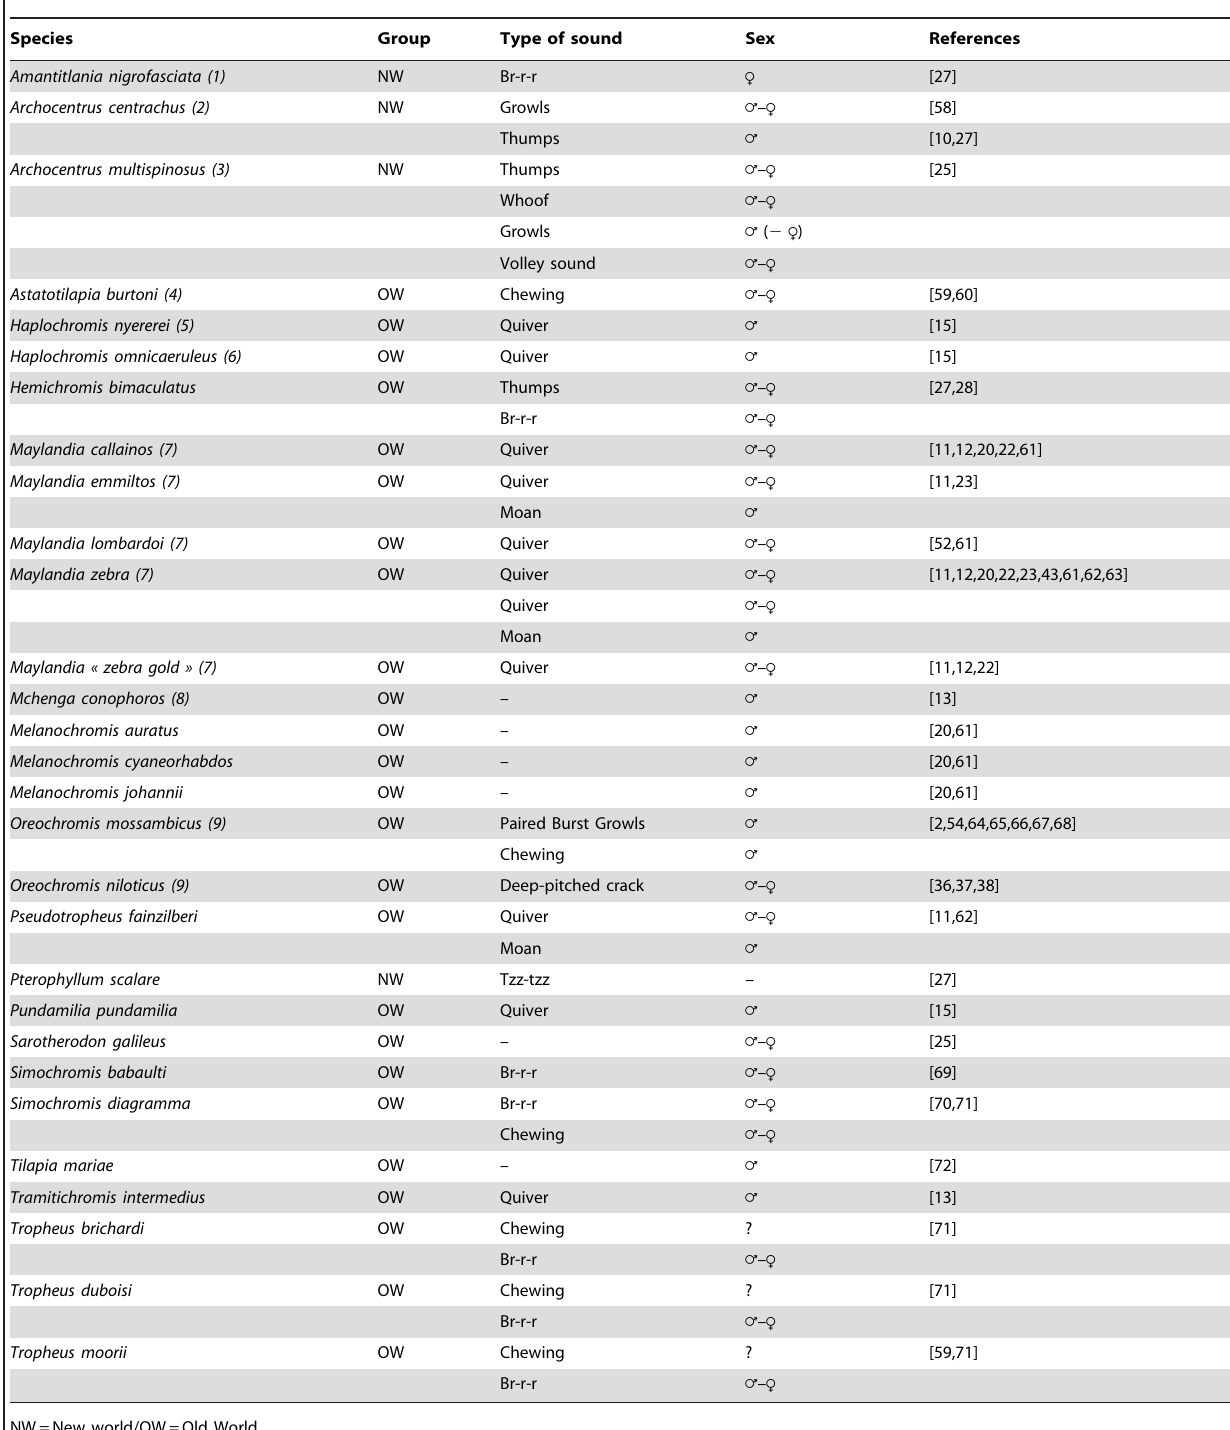
Table 1. Summary of Cichlid species producing sounds referenced in the literature.